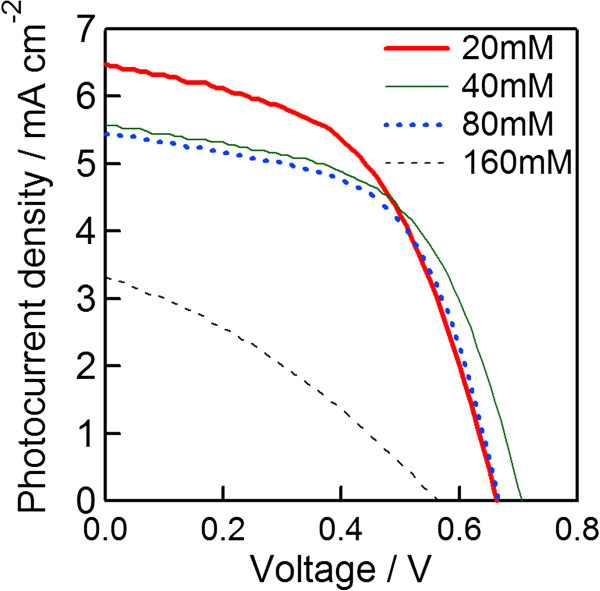
Photocurrent density-voltage curves of selenium solar cells with various H2SeO3concentrations. The annotation numbers in Figure 8 suggest the H2SeO3 concentrations.